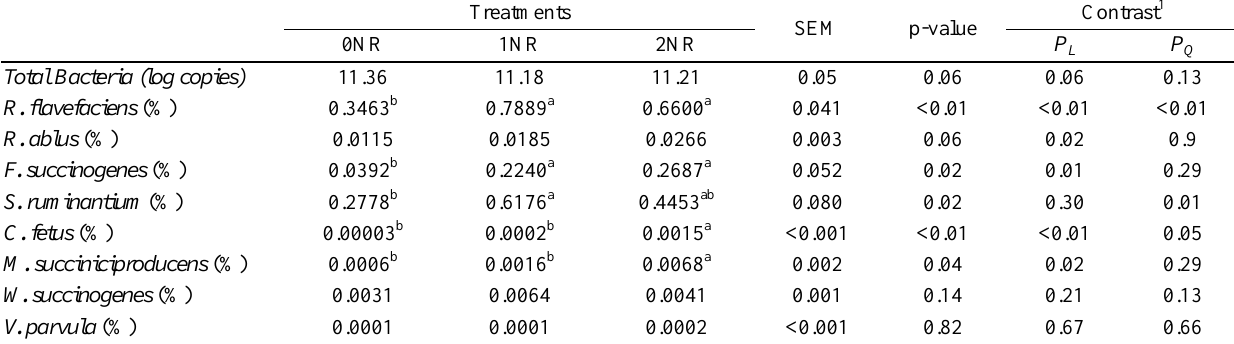
Table 5. Influence of nitrate on total bacteria, cellulolytic and nitrate-reducing bacteria abundance using qPCR technology